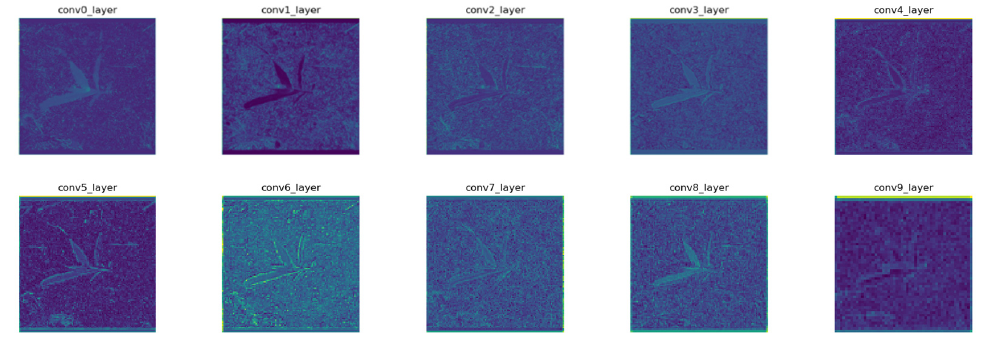
Figure 14. Visualization of the first 10 layers of YOLOv3.